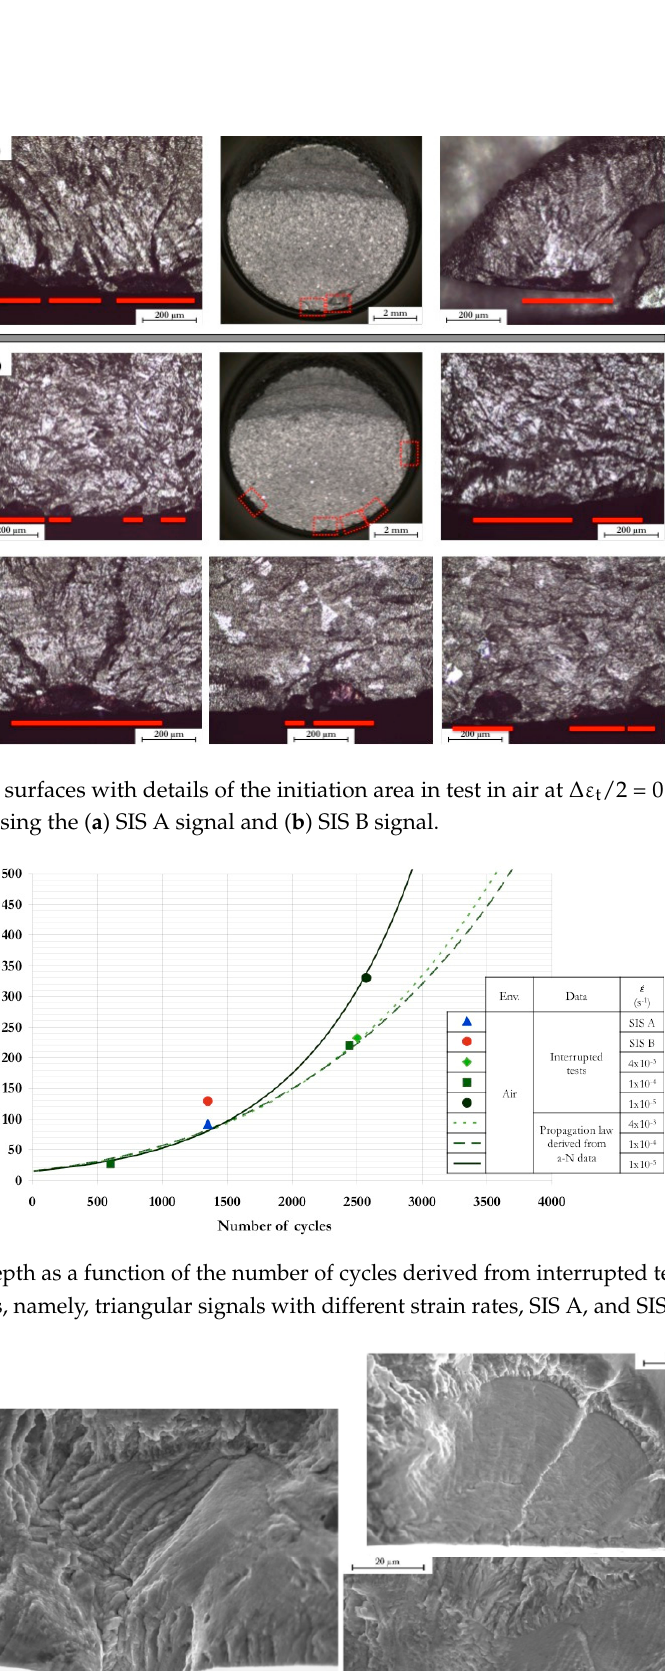
7 of 20 Figure 4. Peak stress as a function of the number of cycles in air with triangular signals at different strain rates and with SIS A and SIS B signals. Samples from interrupted tests were fatigued to failure under load control at high frequency. The residual number of cycles to failure, N R , can be considered as a damage indicator, using the assumption that, for a same stress amplitude during HCF loading, the lower the N r value, the higher the damage extend after the 1350 initial LCF cycles. The values reported in Table 3 indicate a higher damage induced by the SIS B signal. The fracture surfaces were then carefully examined, with a special attention to the initiation area as exemplified in Figure 5. The damage has been quantitatively assessed by determining the maximum crack depth, the surface crack length of this main crack and the total cracked area on the fracture surface. These results, reported in Table 3, confirm the enhanced damaging effect of the SIS B signal, regardless of the parameter under consideration. Additionally, it should be mentioned that the crack shape features generated under these complex waveshapes are